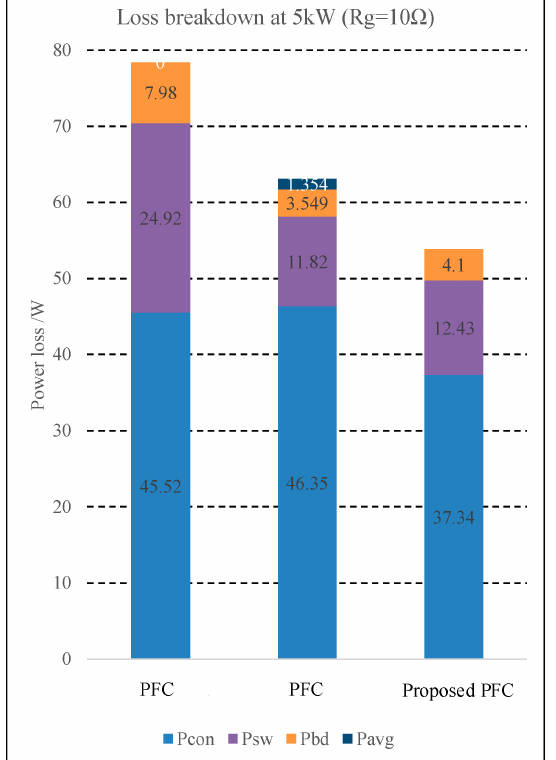
Figure 10. Simulation semiconductor losses of the prior PFCs in [18,26] and the PFC in this